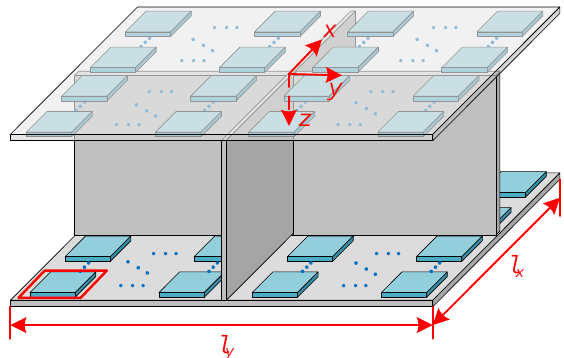
Figure 3. Detail view of a periodic element of the research structure (the top plate is transparent).